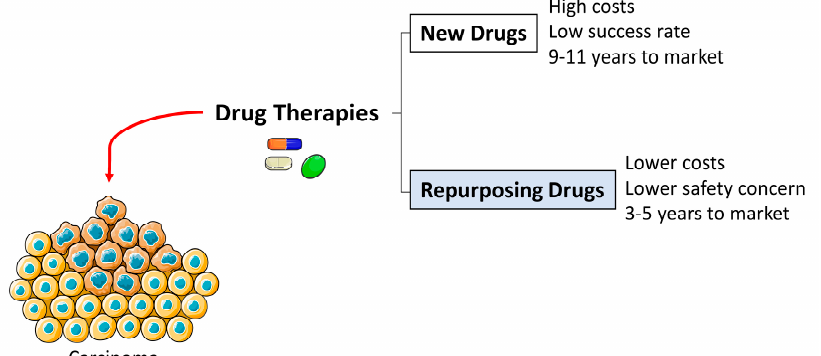
Figure 2. Drug Repurposing advantages over the discovery and development of new drugs for cancer treatment.